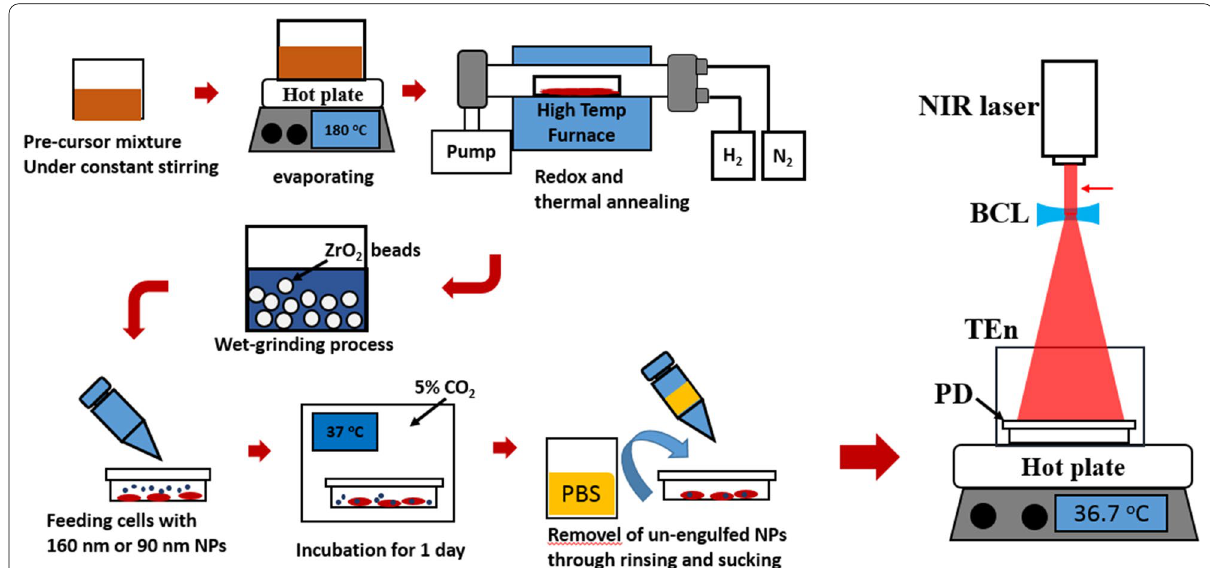
Fig. 1 Schematic illustration of experimental procedures for material synthesis, cellular incubation with NPs and photothermal assay upon the cancer cells. BCL, TEn and PD are the abbreviation stood for bi‑concave lens, thermal enclosure and petri dish, respectively; the red arrow indicates the location for the beam profile